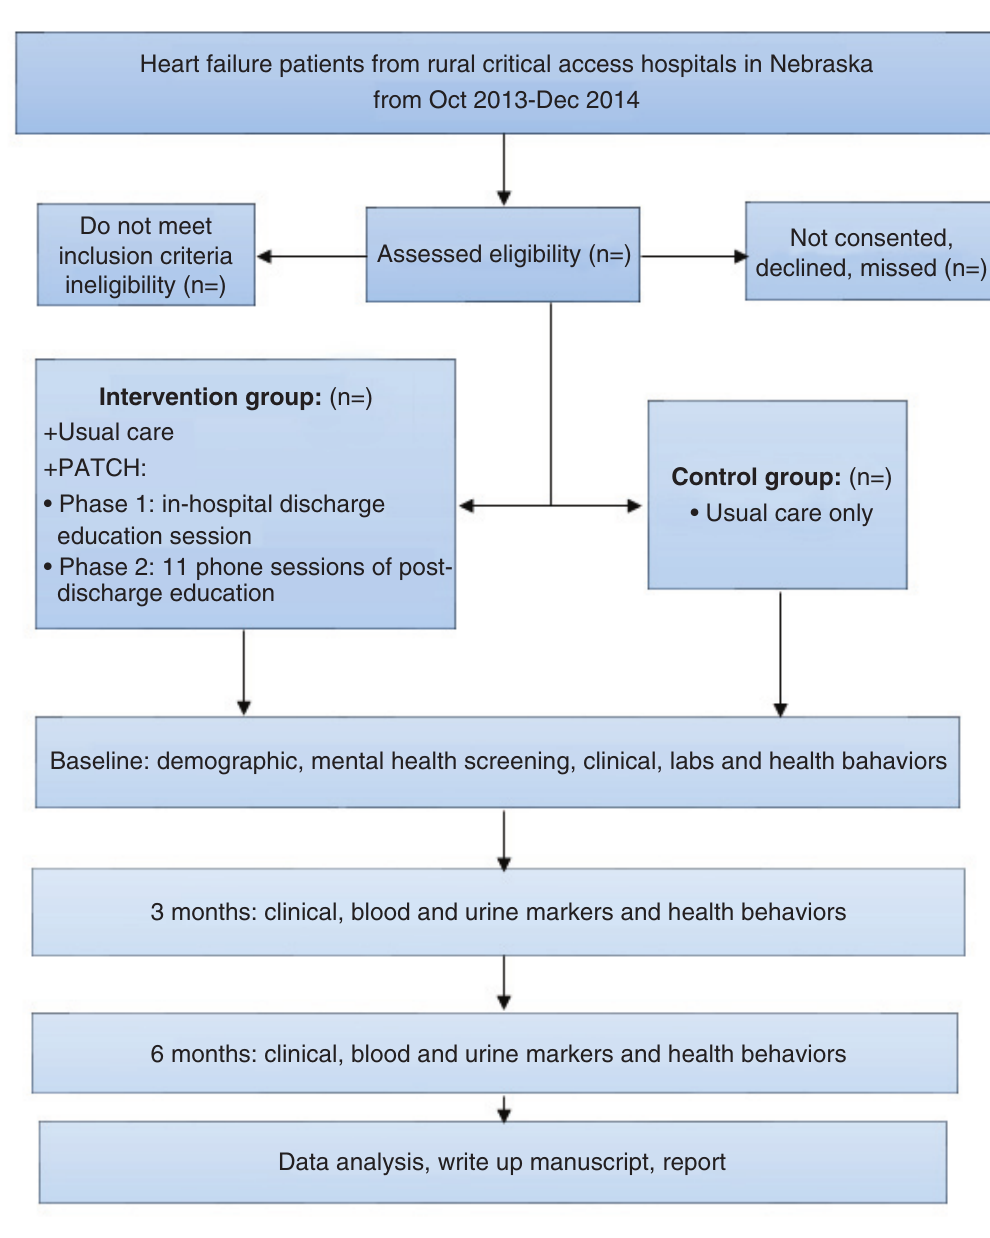
Figure 2. Promoting Self-management through Adherence among Heart Failure Patients Discharged from Rural Hospitals- Flow Chart of Study